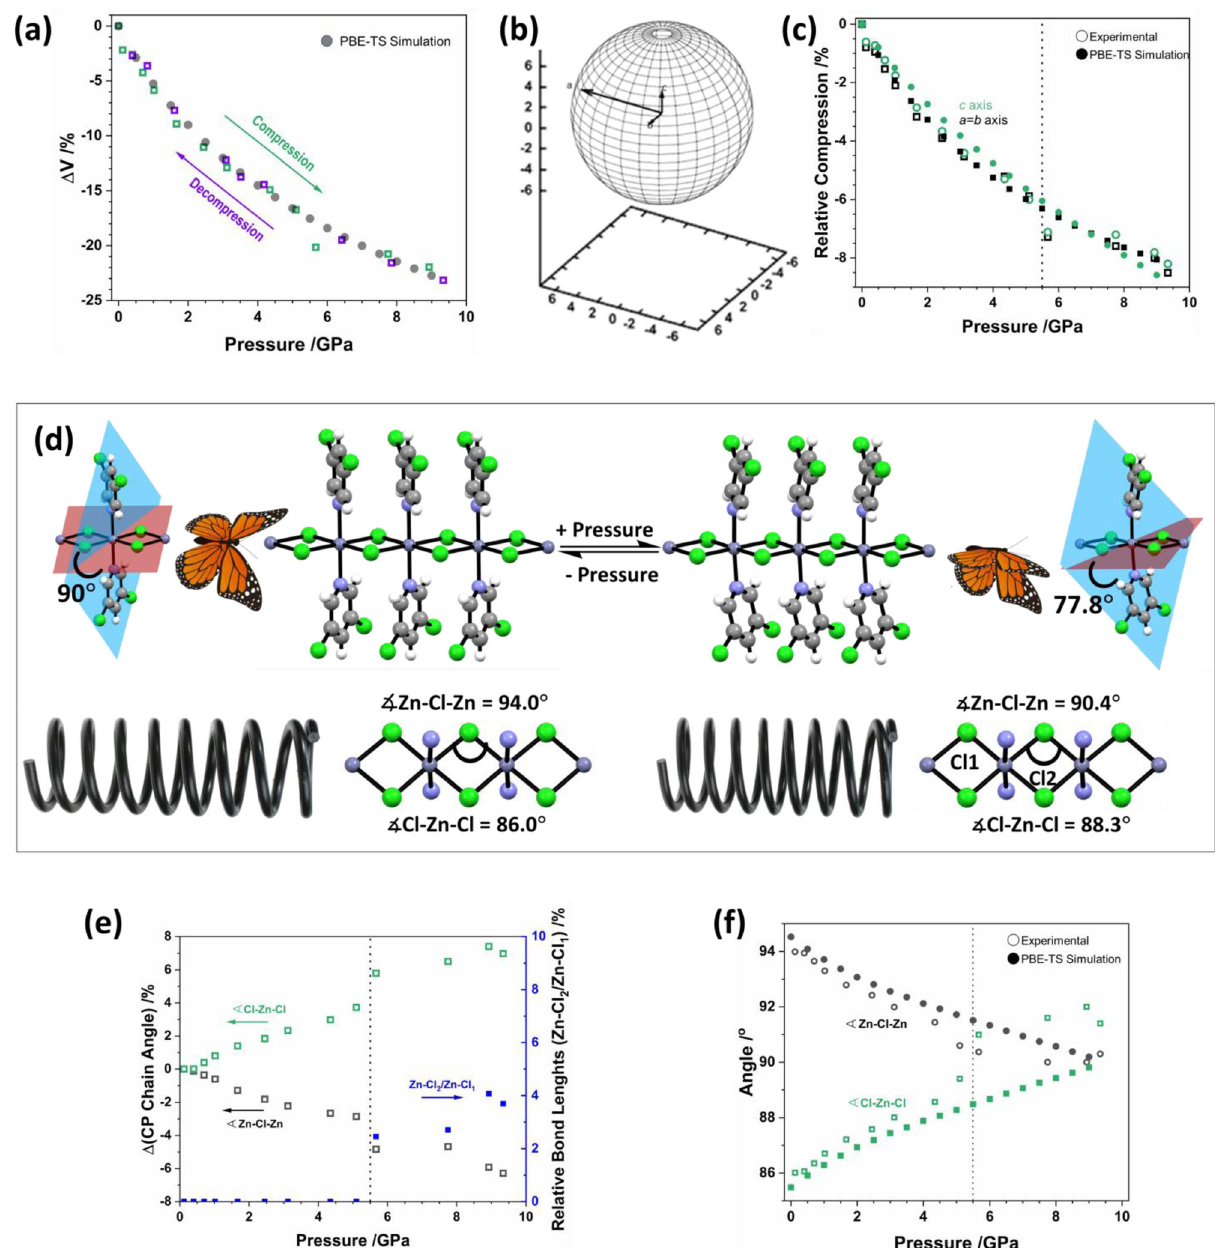
Fig. 2 Effects of high pressure on the crystallographic structure of (1). a The relative change of the crystallographic unit-cell volume during (green) compression and (purple) subsequent decompression. Unit-cell volumes obtained by PBE-TS simulations are shown in black. The phase transition point is indicated by a vertical dotted line. b The compressibility indicatrix obtained from the pressure derivatives of the unit-cell axes of ( 1 ) to 9.35 GPa. The unit- cell axes are indicated by the inset arrows. c The relative change of the crystallographic unit-cell axes of ( 1 ) during compression. Experimental values are shown as open symbols (black squares – a , b axes; green circles – c axis) and PBE-TS values are indicated as closed symbols (black squares – a , b axes; green circles – c axis). The phase transition point is shown with a vertical line. d Effects of the crystallographic phase transition on the CP chain geometry. With increasing pressure, the CP chains are compressed as springs. Across the phase transition, a puckering of the chloro-pyridine ligands occurs. This leads to a signi fi cant change in angle between the planes of the chloro-pyridine ligands and the CP backbone akin to a butter fl y fl ying motion. Zn-Cl-Zn is marked in the CP chains. e Evolution of CP chain geometry with increasing pressure; (green) relative change in Cl-Zn-Cl, (black) relative change in Zn-Cl- Zn, (blue) relative change in Cl-Zn bond lengths. Note that symmetry breaking at the phase transition leads to two unique Zn-Cl distances (Zn-Cl1; Zn-Cl2) as indicated in d . No divergence of Zn-Cl-Zn is observed over the phase transition. f Change in Zn-Cl-Zn and Cl-Zn-Cl angles as a function of pressure, obtained by experiment and PBE-TS simulations. The phase transition is marked by a vertical line in e and f the resolution available from our simulations, and within the potential energy surface (PES) of the phase transition, Fig. 4b. con fi nes of the harmonic phonon approximation, only a single With increasing pressure, the curvature of the PES decreases, energetic minimum is found at each pressure. This is consistent consistent with mode softening. By 4.5 GPa the minimum energy with a continuous (second-order) phase transition in ( 1 ). point on the A 2 PES shifts from η = 0 to η = ±4. Importantly, at